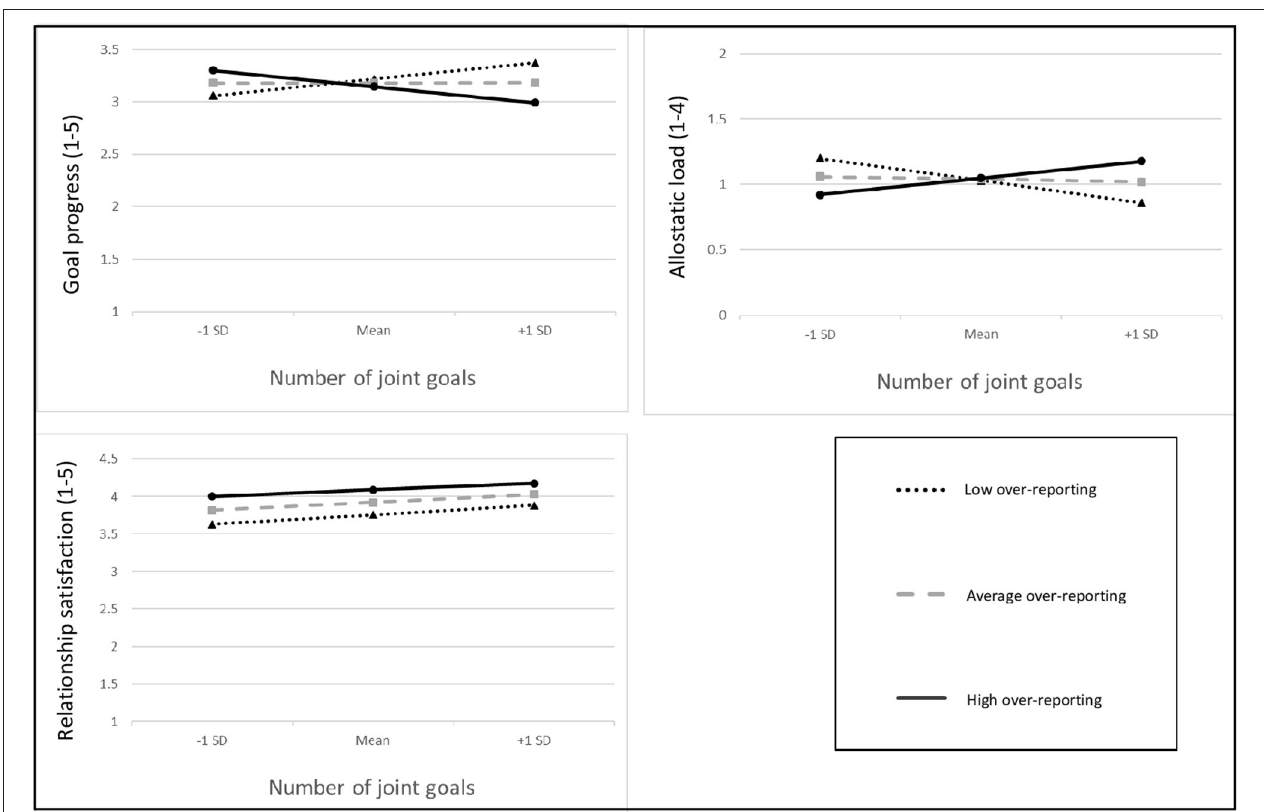
FIGURE 1 | Interactions between the number of joint goals and over-reporting in explaining goal progress (upper left-hand panel), allostatic load (upper right-hand panel), and relationship satisfaction (lower left-hand panel). A larger number of joint goals is related to increased goal progress and lower allostatic load, but only for participants with few over-reporting. In contrast, a higher number of joint goals and more over-reporting are generally linked to higher relationship